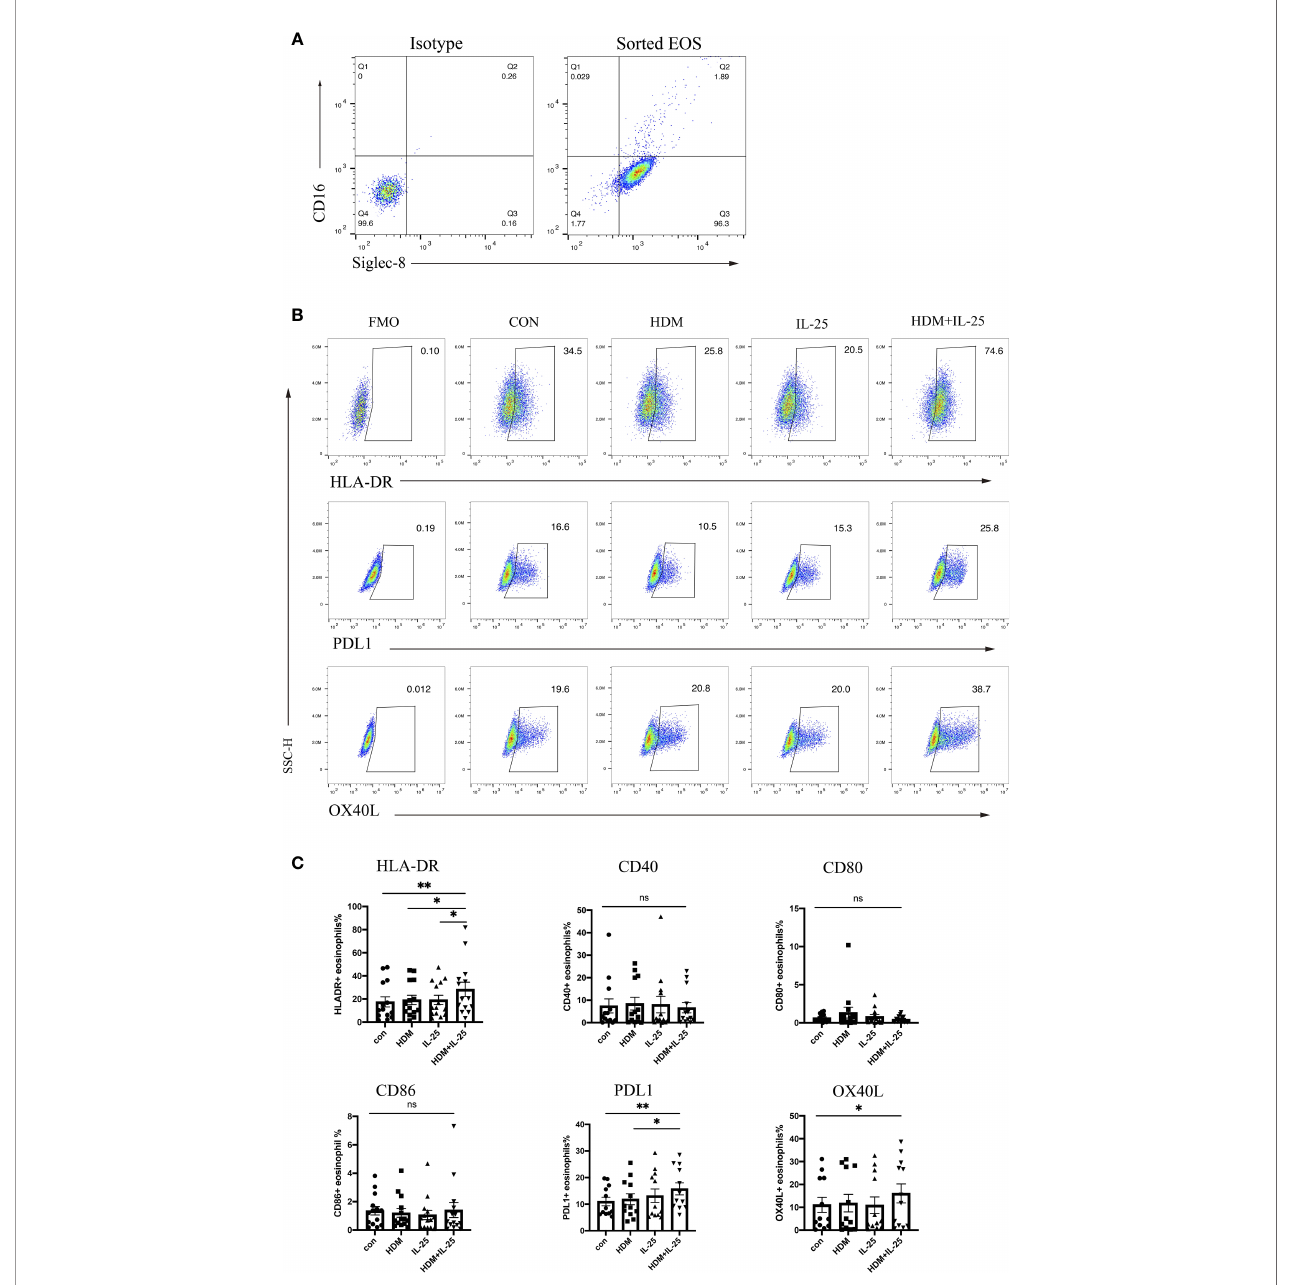
FIGURE 1 | IL-25 and HDM co-promote expression of surface HLA-DR, PD-L1, and OX-40L on eosinophils. (A) FACS plots of the purity for eosinophils (CD16 - Siglec - 8 + cells) after sorting. (B) Gated on viable eosinophils (Zombie - CD16 - Siglec-8 + cells), expression rates of CD40, HLA-DR, CD80, CD86, PD-L1, and OX-40L in the presence or absence of HDM and/or IL-25 were tested by fl ow cytometry. (C) Graphs showed expression rates of CD40, HLA-DR, CD80, CD86, PD-L1, and OX-40L on eosinophils from allergic asthma patients. n = 14, ns, no signi fi cant difference, **p < 0.01, *p <